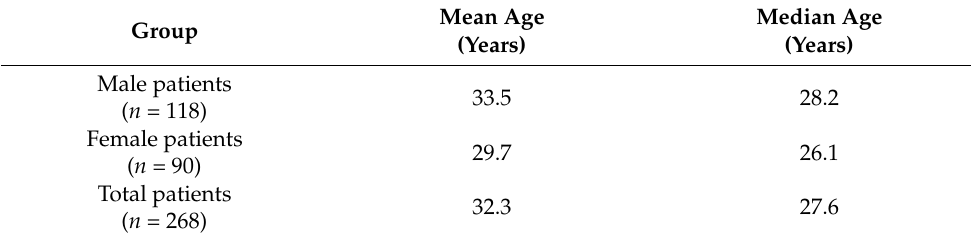
Table 2. Mean and median ages of drug-resistant tuberculosis